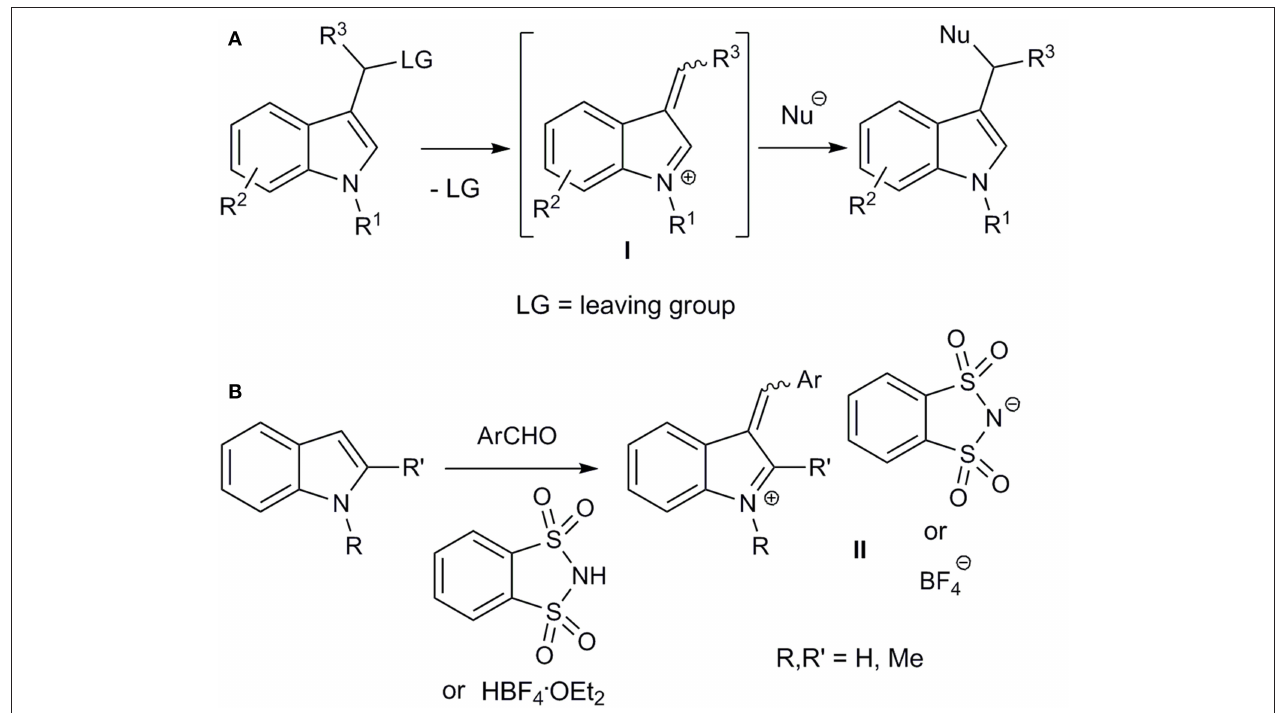
FIGURE 1 | In situ generation of alkylideneindoleninium intermediates (A) and synthesis of stable aryl(indol-3-yl)methylium salts (B)